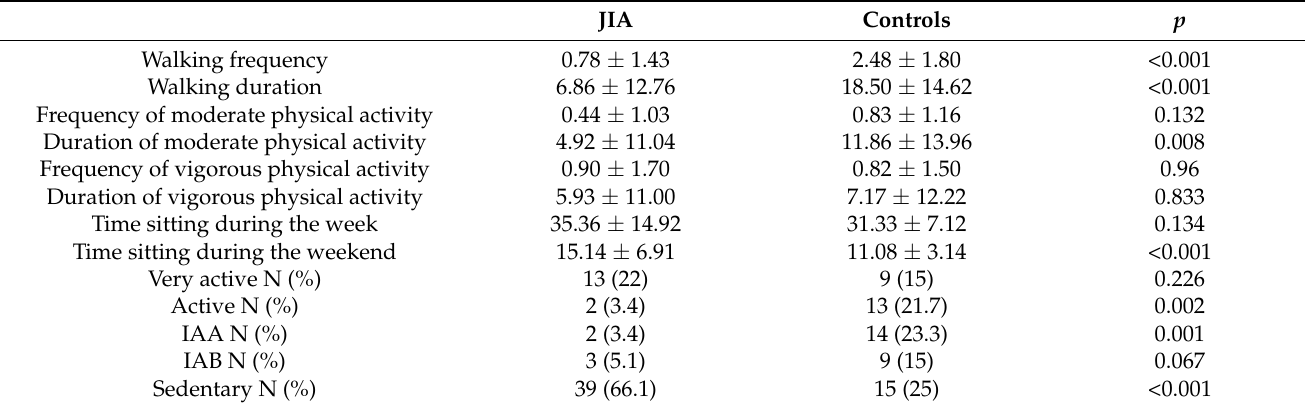
Table 4. Comparison between the means of the International Physical Activity Questionnaire (IPAQ).